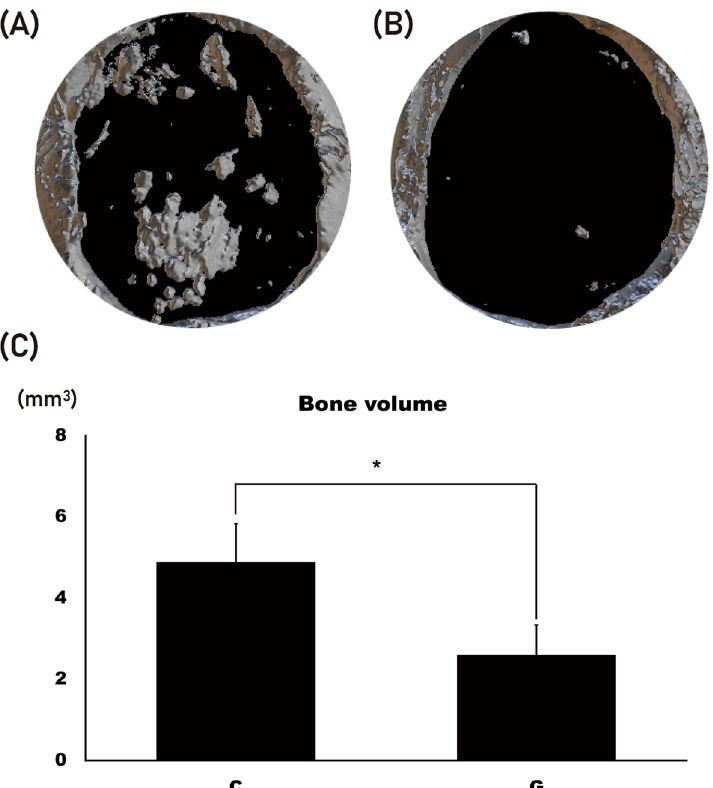
Fig. 2 The results from micro‑CT analysis. A The collagen group (group C) showed multiple calcified nodules in the bony defect. B The gelatin group (group G) also showed bone regeneration. However, it was less active compared with the collagen group. C Bone volume (BV) was measured in the region of interest. BV was significantly higher in group C than in group G (* P =